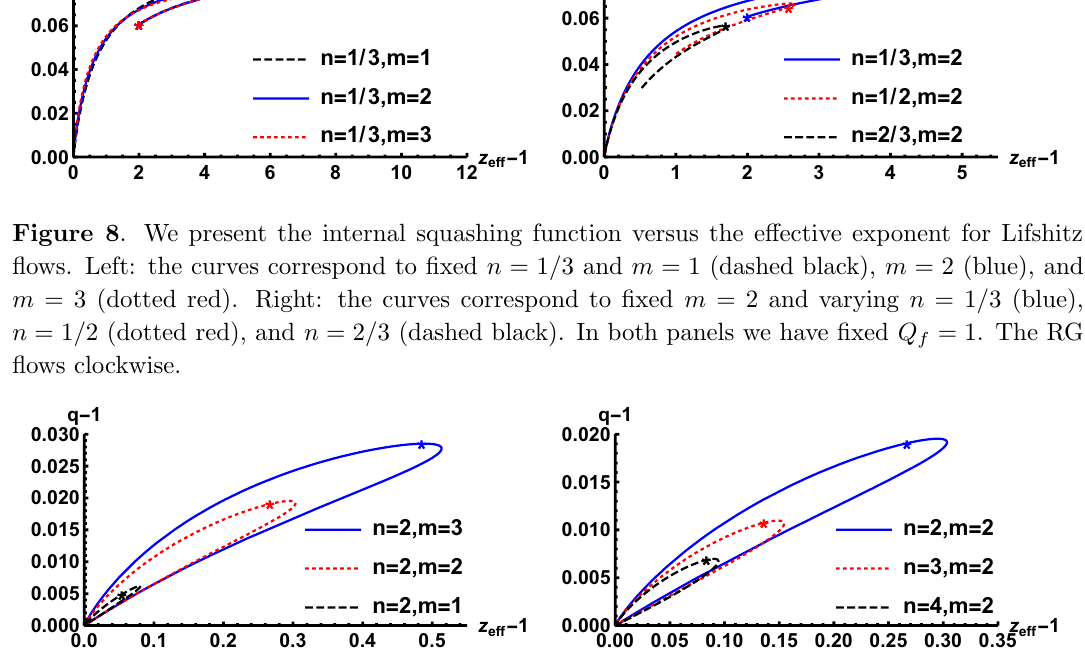
Figure 9 . We present the internal squashing function versus the e(cid:11)ective exponent for boomerang (cid:13)ows. Left: the curves correspond to (cid:12)xed n = 2 and m = 1 (blue), m = 2 (dotted red), and m = 3 (dashed black). Right: the curves correspond to (cid:12)xed m = 2 and varying n = 2 (blue), n = 3 (dotted red), and n = 4 (dashed black). In both panels we have (cid:12)xed Q f = 1. The RG (cid:13)ows